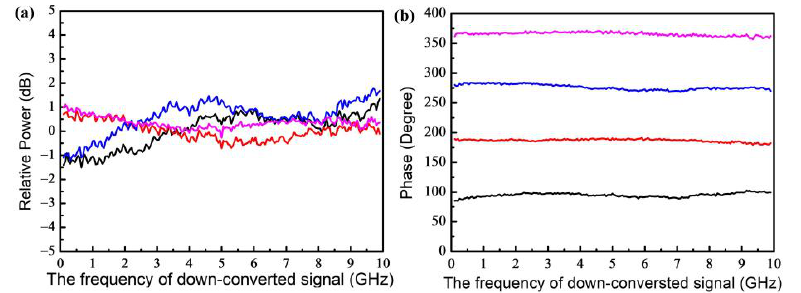
Figure 7. Measured ( a ) power response and ( b ) phase response of the microwave photonic mixer working in the down-conversion mode, where the RF signals in the range of 10.1 GHz to 19.9 GHz are down-converted to the range of 0.1 GHz to 9.9 GHz by using an LO signal at 10 GHz.